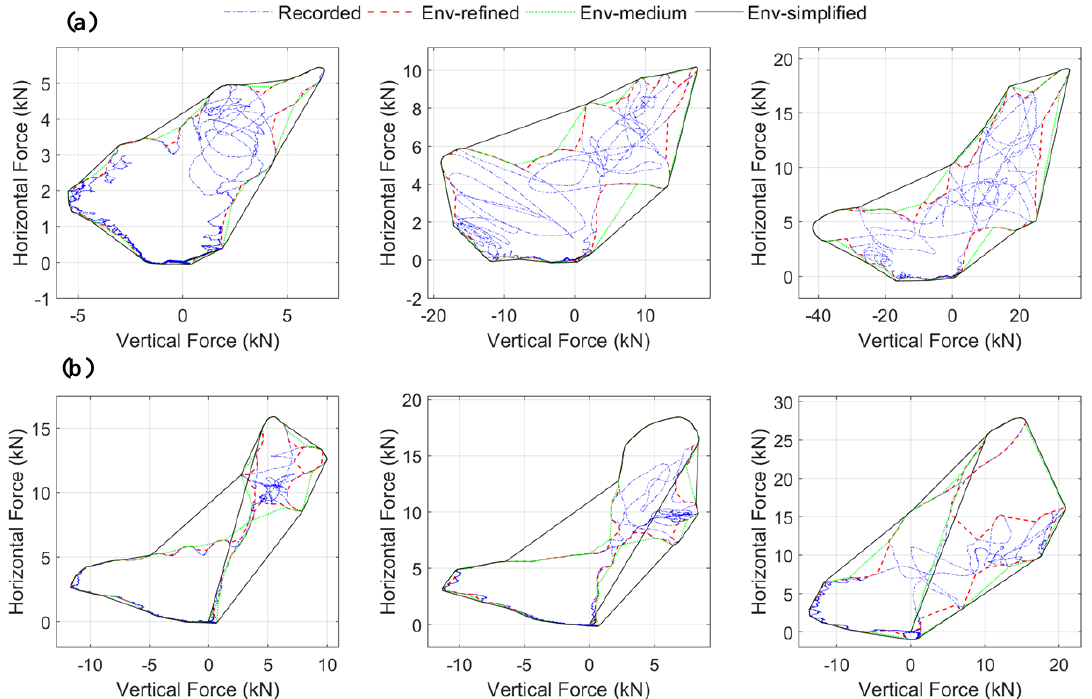
Figure 15. Demand diagrams of vertical and horizontal force for ( a ) solitary waves (top) with H = 0.42 m (left), H = 0.55 m (center), H = 0.70 m (right), and ( b ) bores (bottom) with H = 1.0 m (left), H = 1.10 m (center) and H = 1.40 m (right).